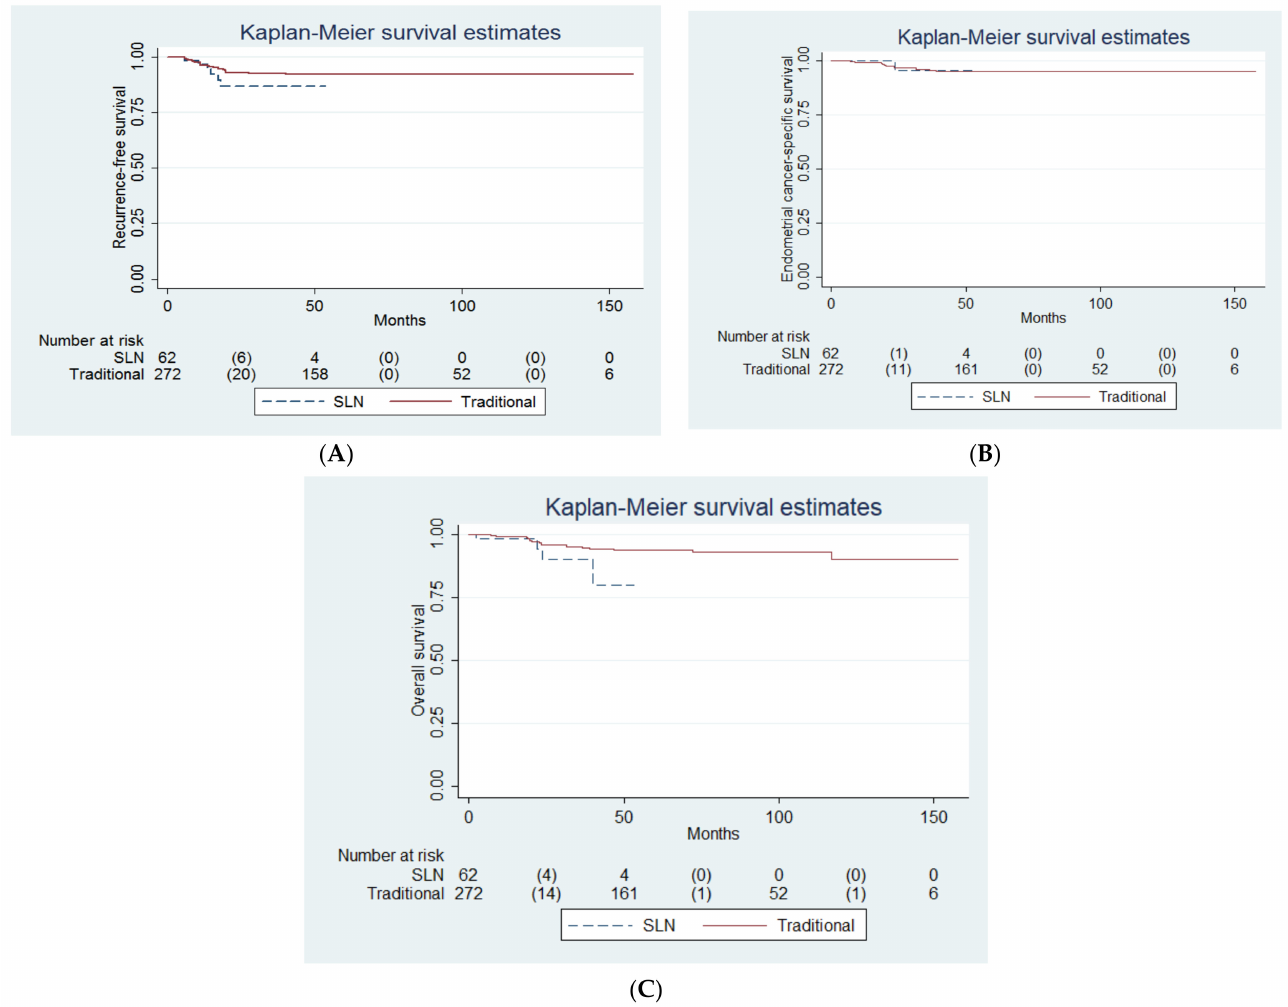
Figure 2. Probabilities of ( A ) recurrence-free survival, ( B ) endometrial cancer-specific survival, and ( C ) overall survival between the traditional lymphadenectomy and sentinel lymph node mapping groups in women with clinically uterine-confined endometrial cancer ( n =